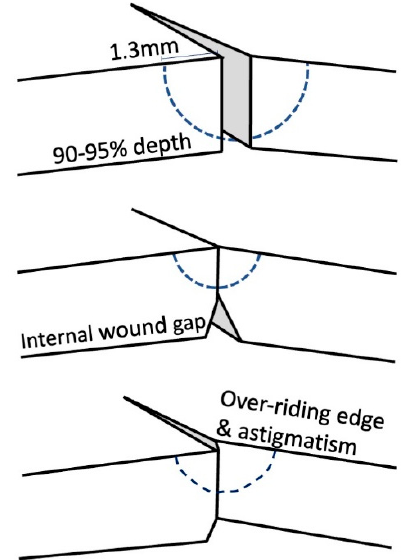
Figure 2. Demonstration of suture depth. 1. Ideal suture depth. 2. Shallow suture. 3. Unequal su- tures.